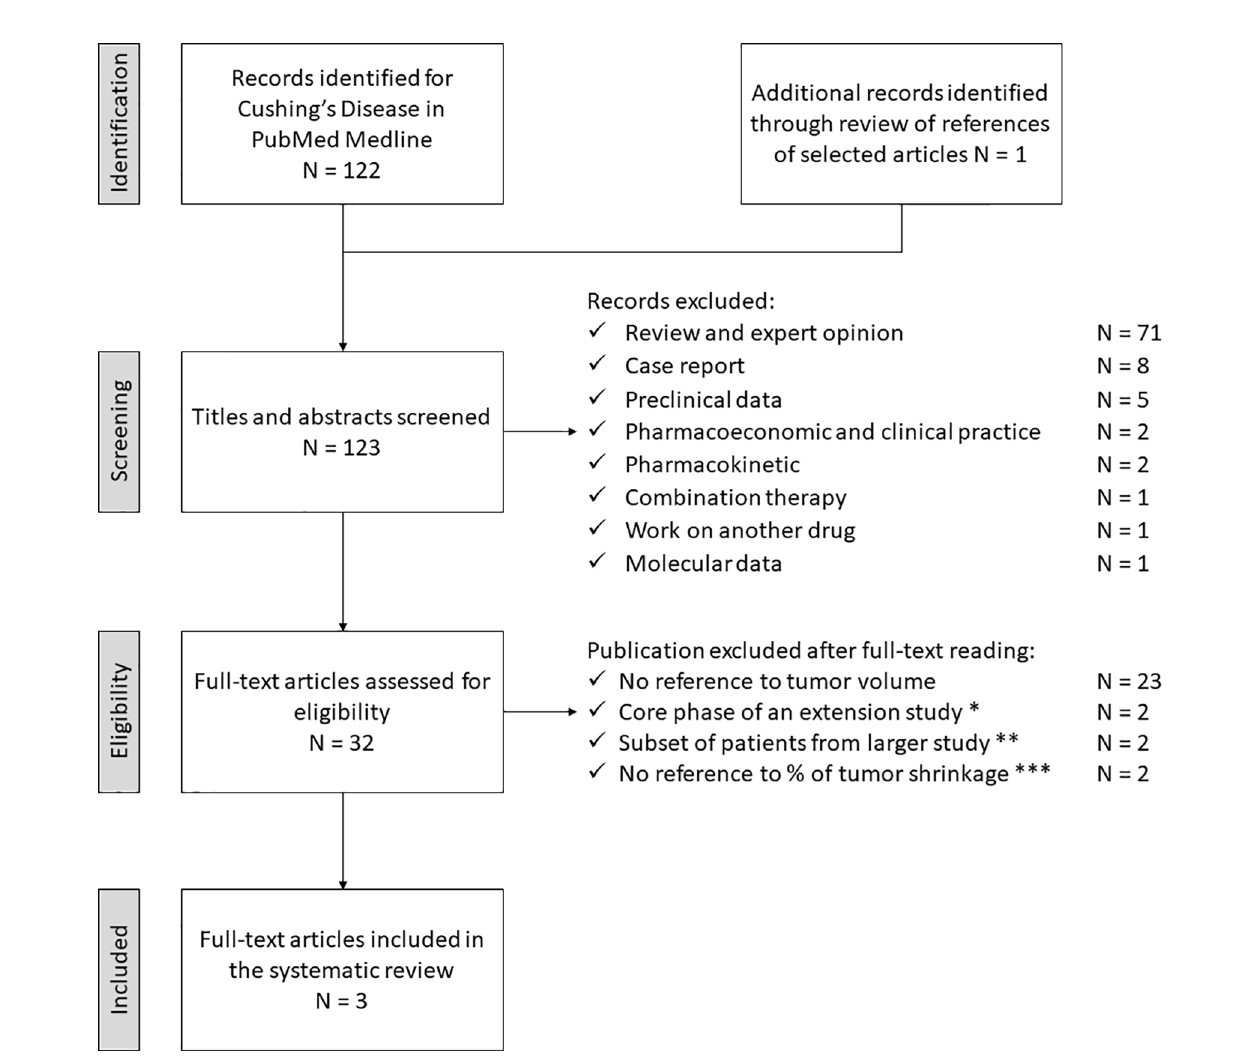
FIGURE 3 | Search strategy for Cushing ’ s Disease. * Lacroix A, 2018 (PAS LAR, phase III) and Lacroix A, 2020 (PAS sc, phase III post-hoc analysis). ** Simeoli C, 2014 (PAS sc) and Colao A 2012 (PAS sc, phase III). *** Daniel E, 2018 (PAS sc and LAR) and Trementino L, 2016 (PAS sc). PAS, pasireotide, sc, subcutaneous, LAR, long acting